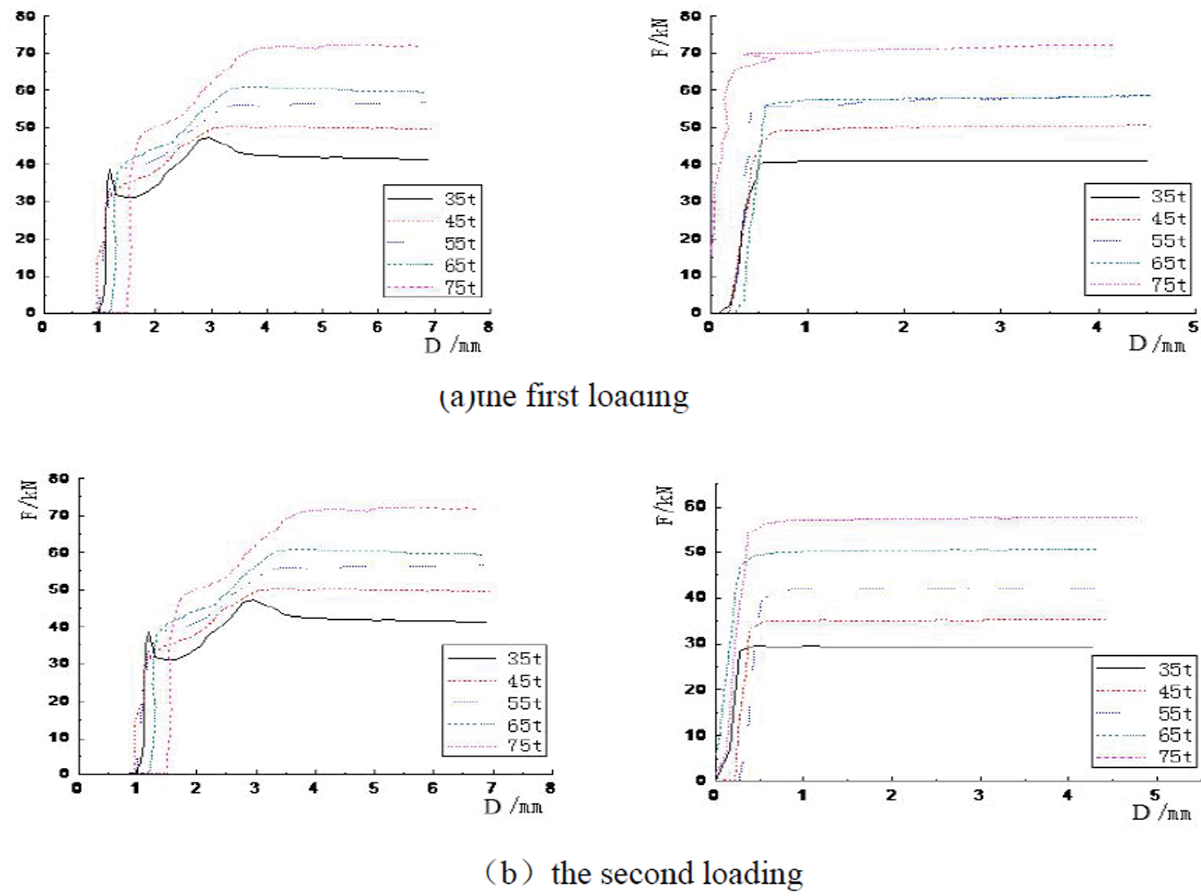
Figure 8. The restoring force model experiments It shows that this restoring force model accords with the coulomb friction model. So it indicates that the design of the new friction sliding isolation bearing as isolation bearing friction materials is using MoS 2 reasonable . The friction efficient can be calculated by the restoring force model. Then the curve of the vertical pressure and the friction factor is shown in Fig.9.